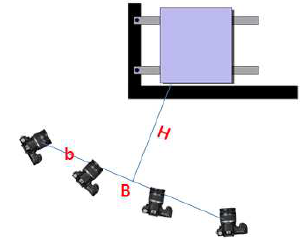
Figure 2: Shaking table test. B is the longest distance between two cameras; b is the baseline between any two adjacent cameras and H is the object distance, as measured from the shaking table to the midpoint of B.